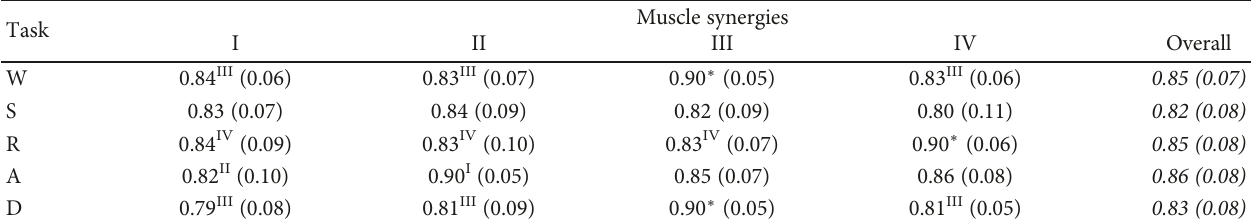
Table 10: Mean value and standard deviations (SDs) related to the B COS evaluated synergy by synergy for each task. Di ff erences between sim pair of synergies in each task are reported in superscript with the relative roman number; ∗ stands for statistical di ff erences among all synergies. The overall means evaluated considering all the synergies together are reported in italic.